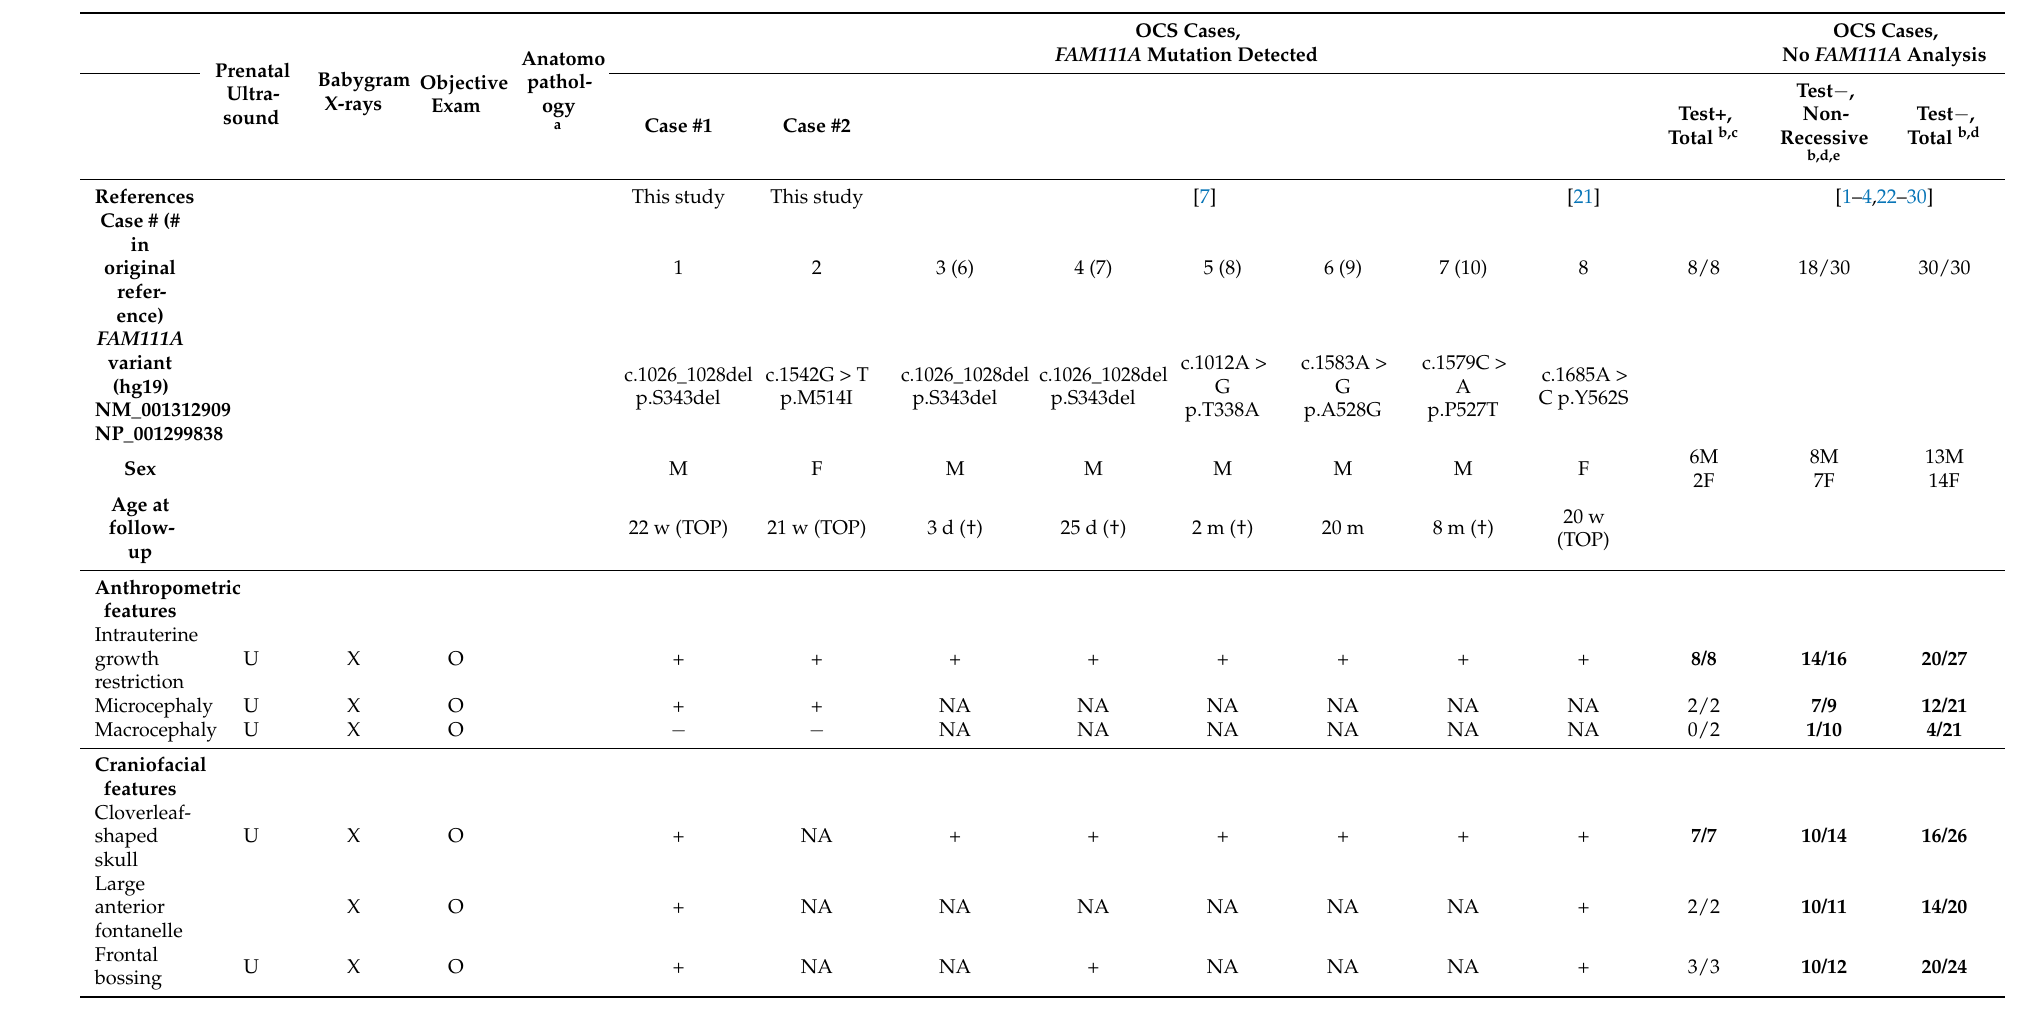
Table 1. Skeletal and clinical features of osteocraniostenosis